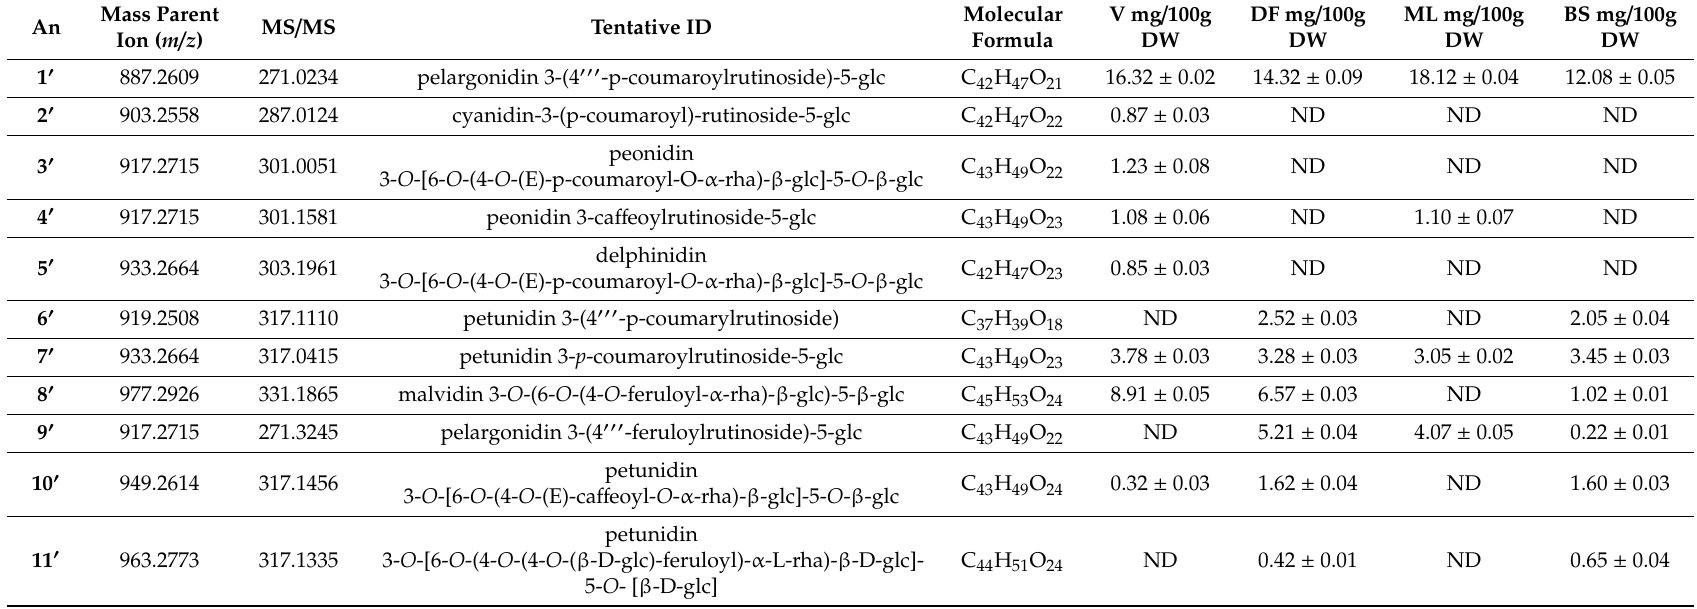
Table 2. HR MS and MS / MS data for the identification of anthocyanins (An) in LC-ESI-QqQ-MS / MS profiles of the PAE from the four S. tuberosum varieties. Mass Parent An MS / MS Tentative ID Ion ( m / z )